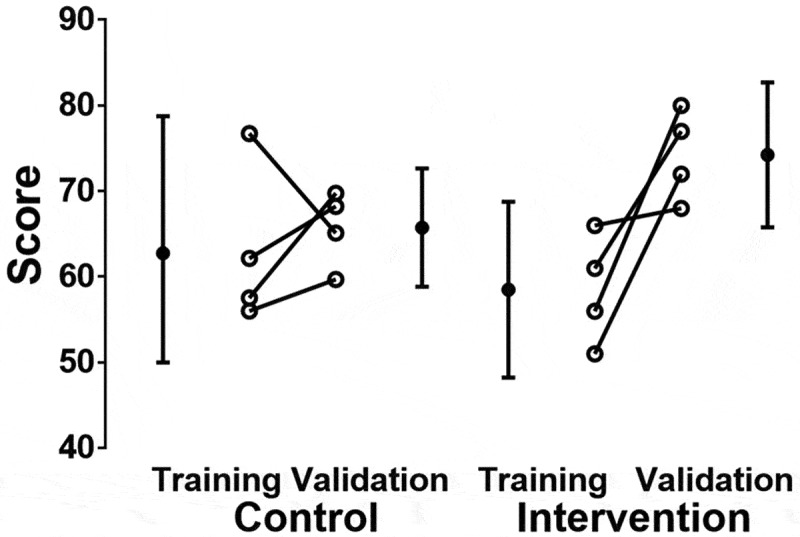
A comparison of the mean percentage score achieved between sessions for the control group and the intervention group using both standard and digital stethoscopes.